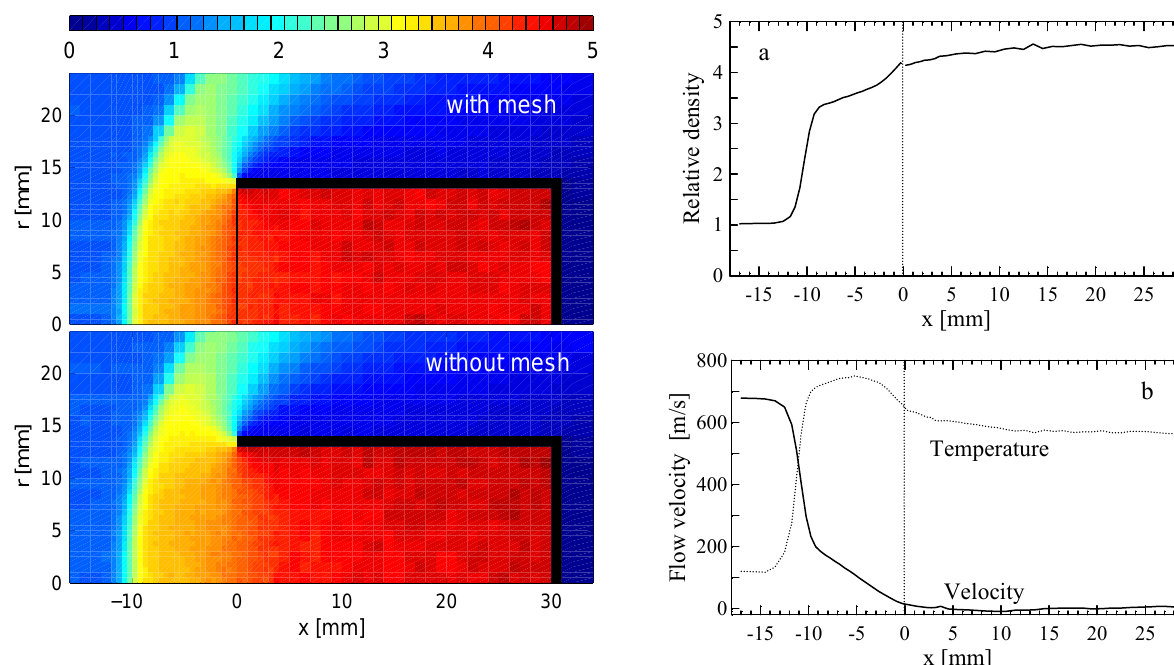
Fig. 7. Simulated flow conditions along the symmetry axis for the flow with mesh in Fig. 6. (a) Density, (b) simulated temperature and axial velocity